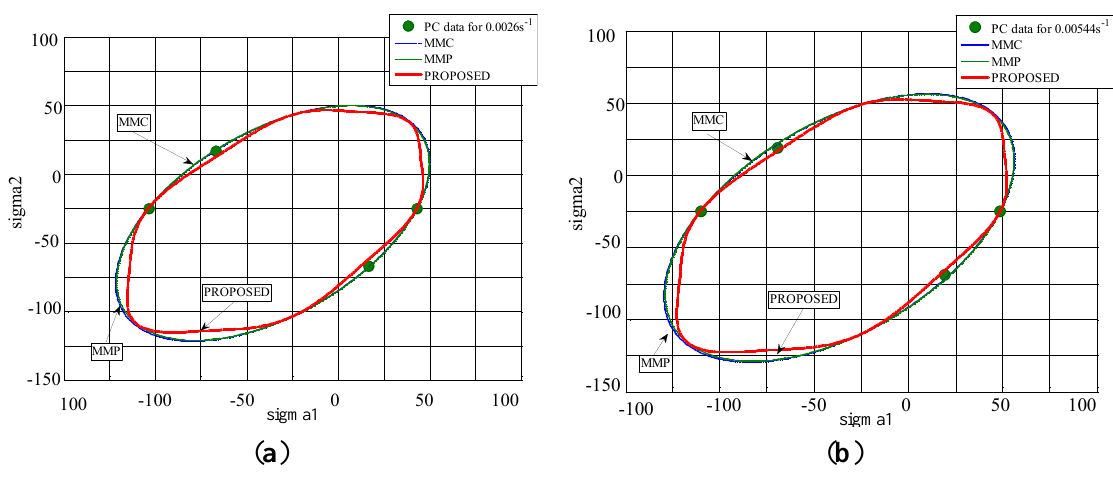
versus σ ): for equivalent strain rate ( a ) 0.0026 s −1 I II